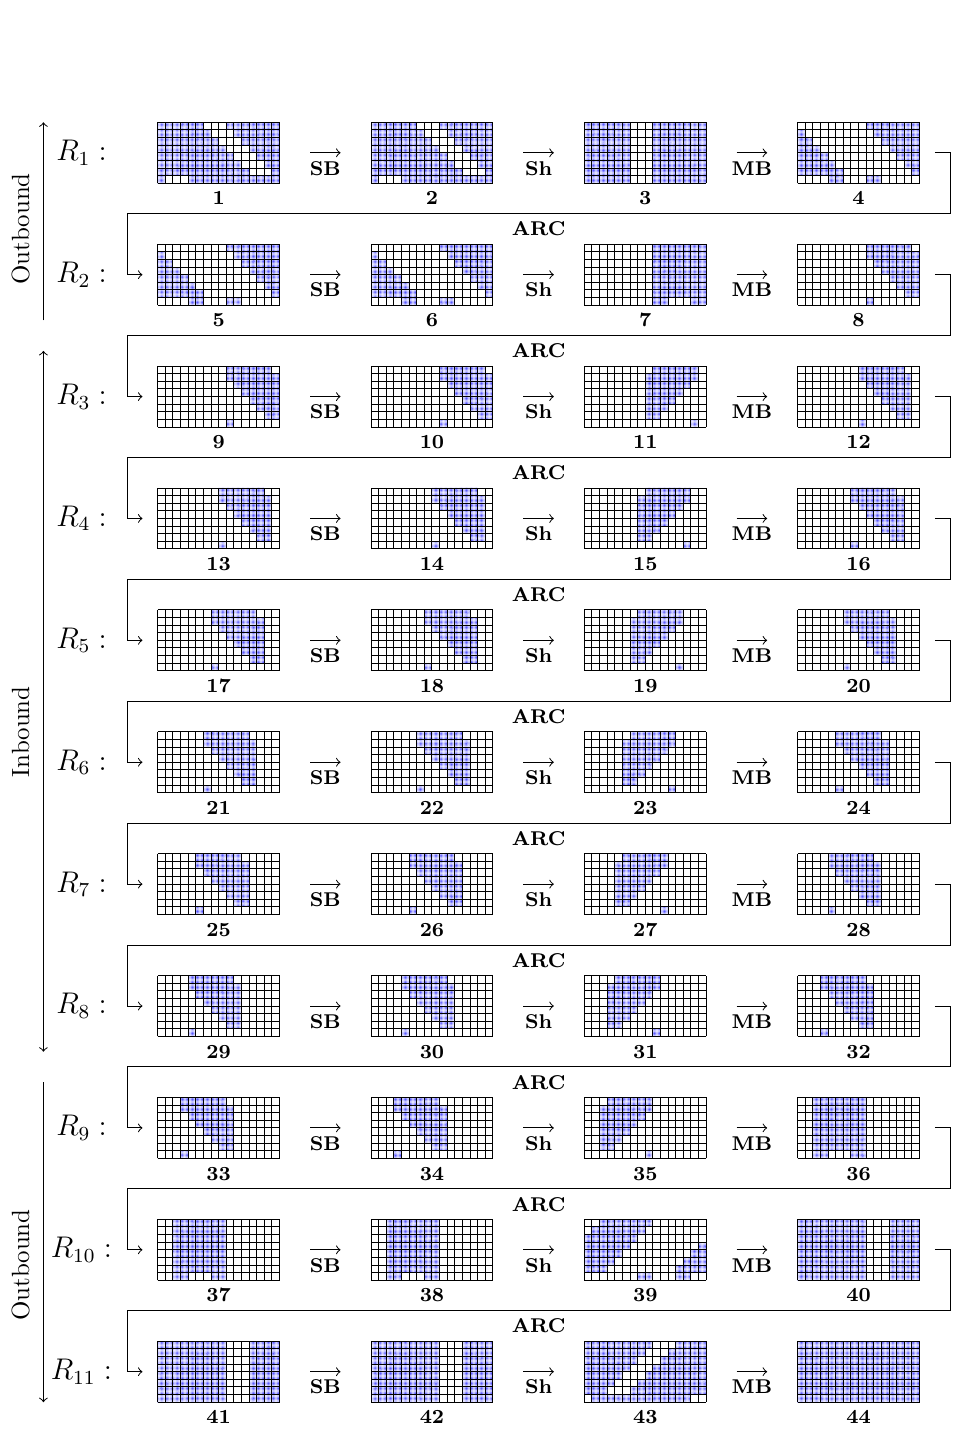
Figure 3: A 11 − round truncated differential path over P 1024 of